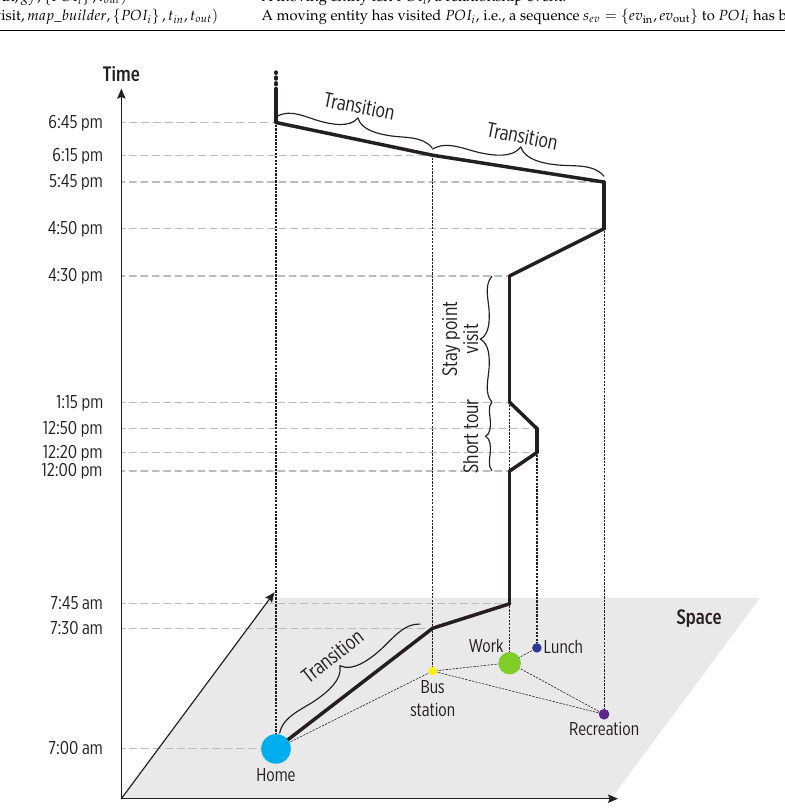
Figure 2. Conceptual representation of an individual’s mobility across space and time using the events related to POIs (enter, exit) as a reference. Adapted from [29]. Reprinted from Transportation Research Part C: Emerging Technologies, Vol 68, Chen, C.; Ma, J.; Susilo, Y.; Liu, Y.; Wang, M., The promises of big data and small data for travel behavior (aka human mobility) analysis, 285–299, Copyright (2016), with permission from